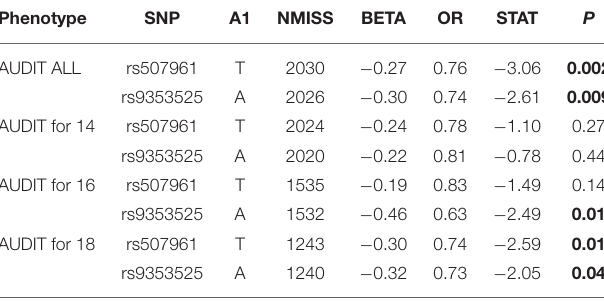
TABLE 3 | Table of results for logistic model with AUDIT and rs9353525 and rs507961.